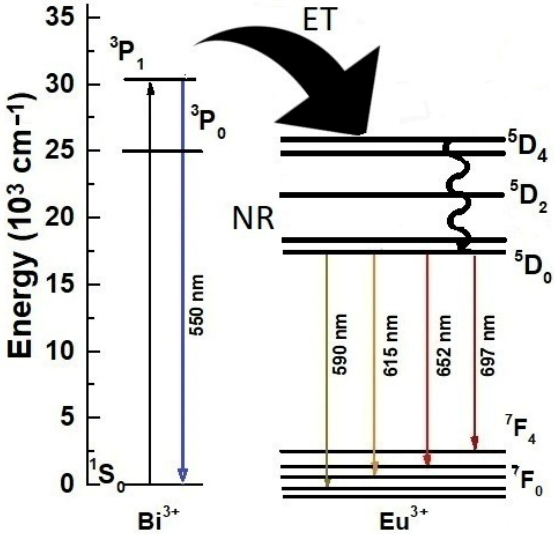
Figure 7. ( a ) Excitation and emission spectra of Bi 3+ and ( b ) Intensity of 550 nm Bi 3+ 1 S 0 → 3 P 1 transition.